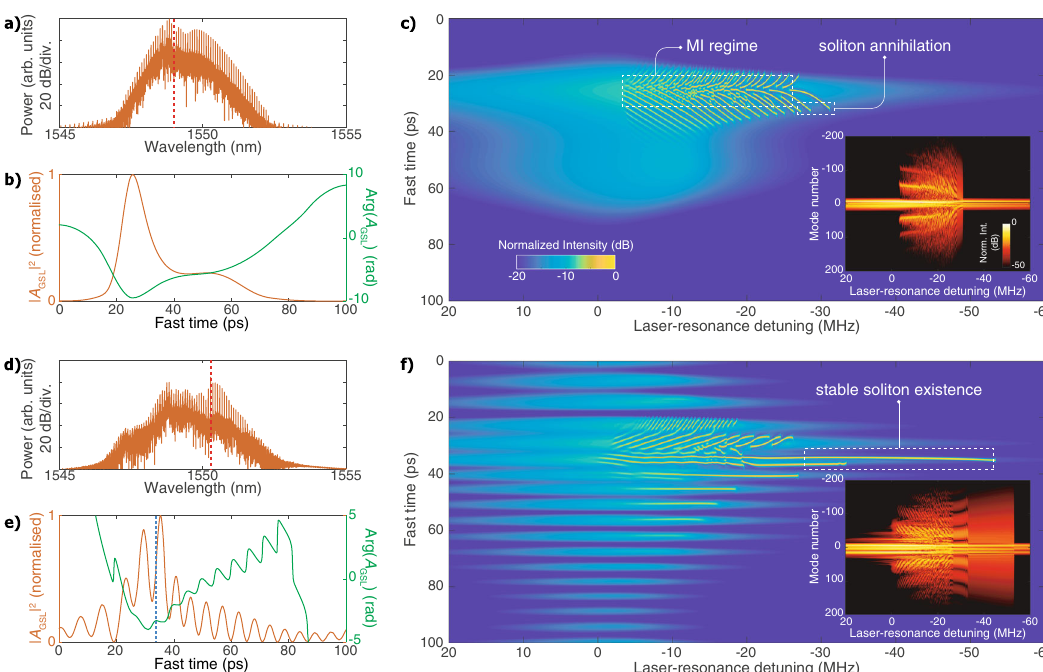
Fig. 3 Simulations of soliton generation with gain-switched laser driving. a Comb spectrum and b pulse intensity and phase of the gain-switched laser when the master laser is injected into the centre of the lasing mode at 1549 nm. The red dashed line indicates the position of the master laser injection. c Intracavity intensity evolution of a Si 3 N 4 microring resonator driven by the GSL pulse in ( b ). MI modulation instability. The inset shows the microcomb spectrum evolution. d Comb spectrum of the gain-switched laser that is offset-injection-locked. The master laser frequency is detuned from the centre of the intrinsic lasing mode by − 160 GHz. e Intensity and phase of the offset-injection-locked GSL pulse. The blue dashed line indicates the phase maximum that has the highest fi eld amplitude. f Intracavity intensity evolution of the microring resonator that is pumped by the pulse in ( e ), showing a single-soliton step with a width of ~20 MHz yielded by a soliton trapped at the phase maximum that is indicated by the dashed line in ( e